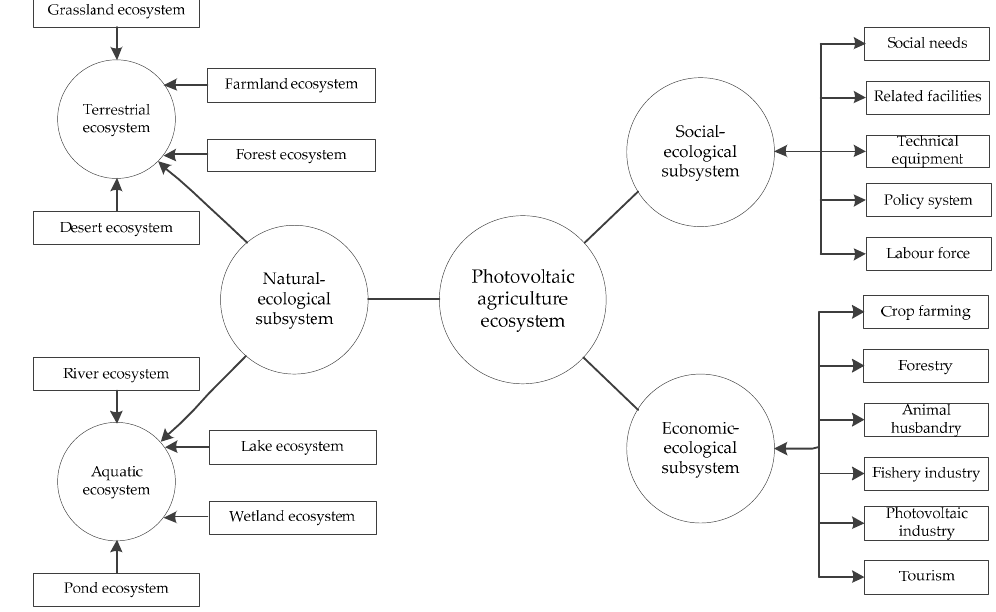
Figure 3. Structure of the ecosystem of photovoltaic agriculture.